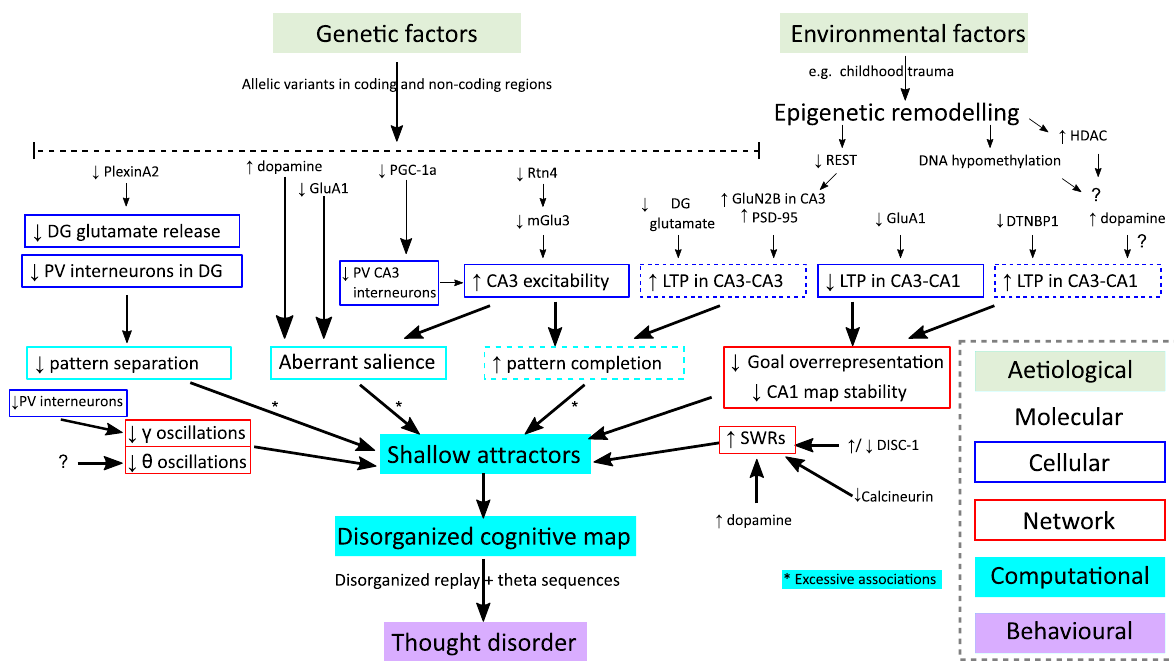
Fig. 3 Convergence of distinct Hippocampal pathways on Thought disorder. Multiple pathways can give rise to thought disorder, either separately or in concert. Both genetic and epigenetic factors contribute to molecular de fi cits in key Hippocampal circuit elements. This in turn gives rise to de fi cits in the activity and plasticity of the cells affected. Such functional changes drive distinct network de fi cits which all converge on shallowing of Hippocampal attractors and hence disorganizing cognitive maps. Cognitive map disorganization is re fl ected in impaired sequential activity of Hippocampal place cells in of fl ine and online states, which we propose drives thought disorder. Dashed lines indicate processes tentatively/indirectly implicated in Schizophrenia. (HDAC Histone Deacetylases, REST repressor element-1 silencing transcription factor, SWRs Sharp-wave ripples, PV Parvalbumin; asterisks (*) signify changes that cause excessive